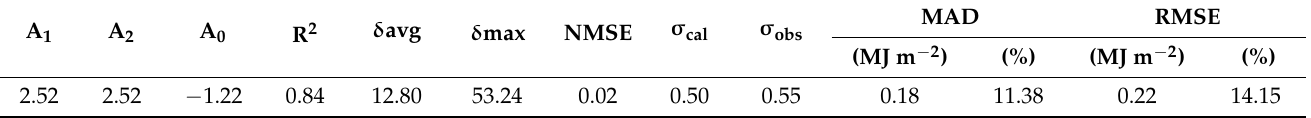
Table 1. The coefficients and constants, coefficient of determination (R 2 ), average and maximum of the absolute relative bias ( δ avg and δ max (%)), normalized mean square error (NMSE), and standard deviations of calculated and observed solar global irradiances ( σ cal and σ obs , respectively). The mean bias error (MAD, MJ m − 2 and %) and the root mean square error (RMSE, MJ m − 2 and %) (n =